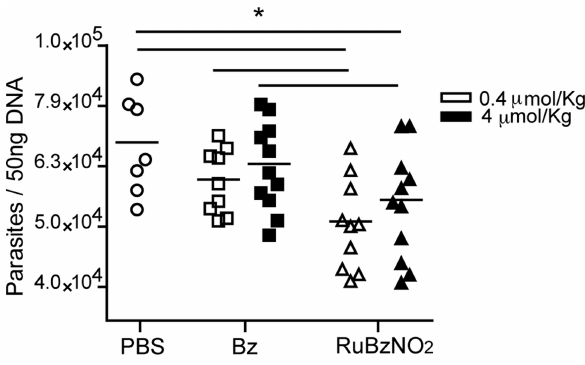
Figure 6. Heart parasitism is reduced after treatment with RuBzNO 2 . Mice were infected with 2000 trypomastigotes of T. cruzi and treated with various concentrations of Bz or RuBzNO 2 . After 20 dpi, the DNA from the heart was isolated, and T. cruzi was quantified with real-time PCR. Each dot indicates an individual mouse, and the graph is representative of two independent experiments. * represents p , 0.05.